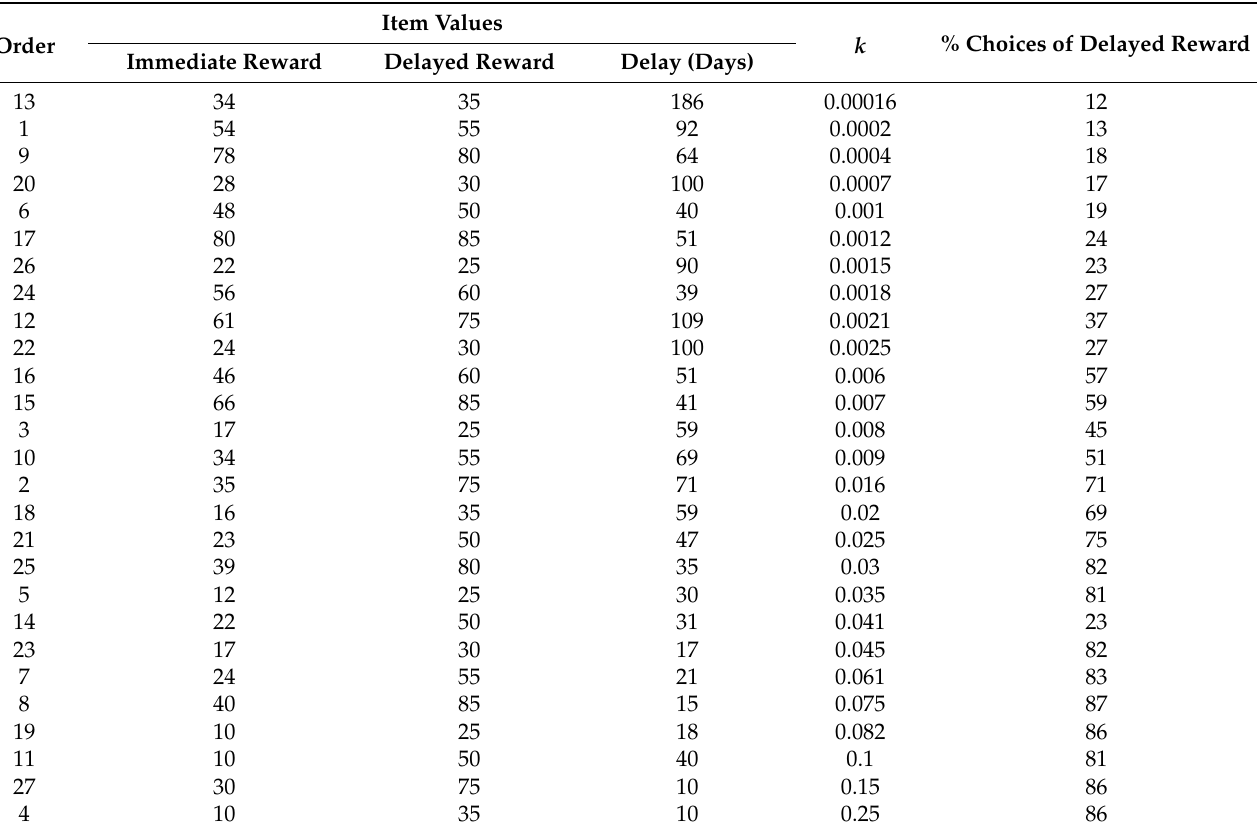
Table A2. Experiment 2 MCQ revised scale items with associated discount parameter ( k ), order of presentation, and proportion of choices in the delayed